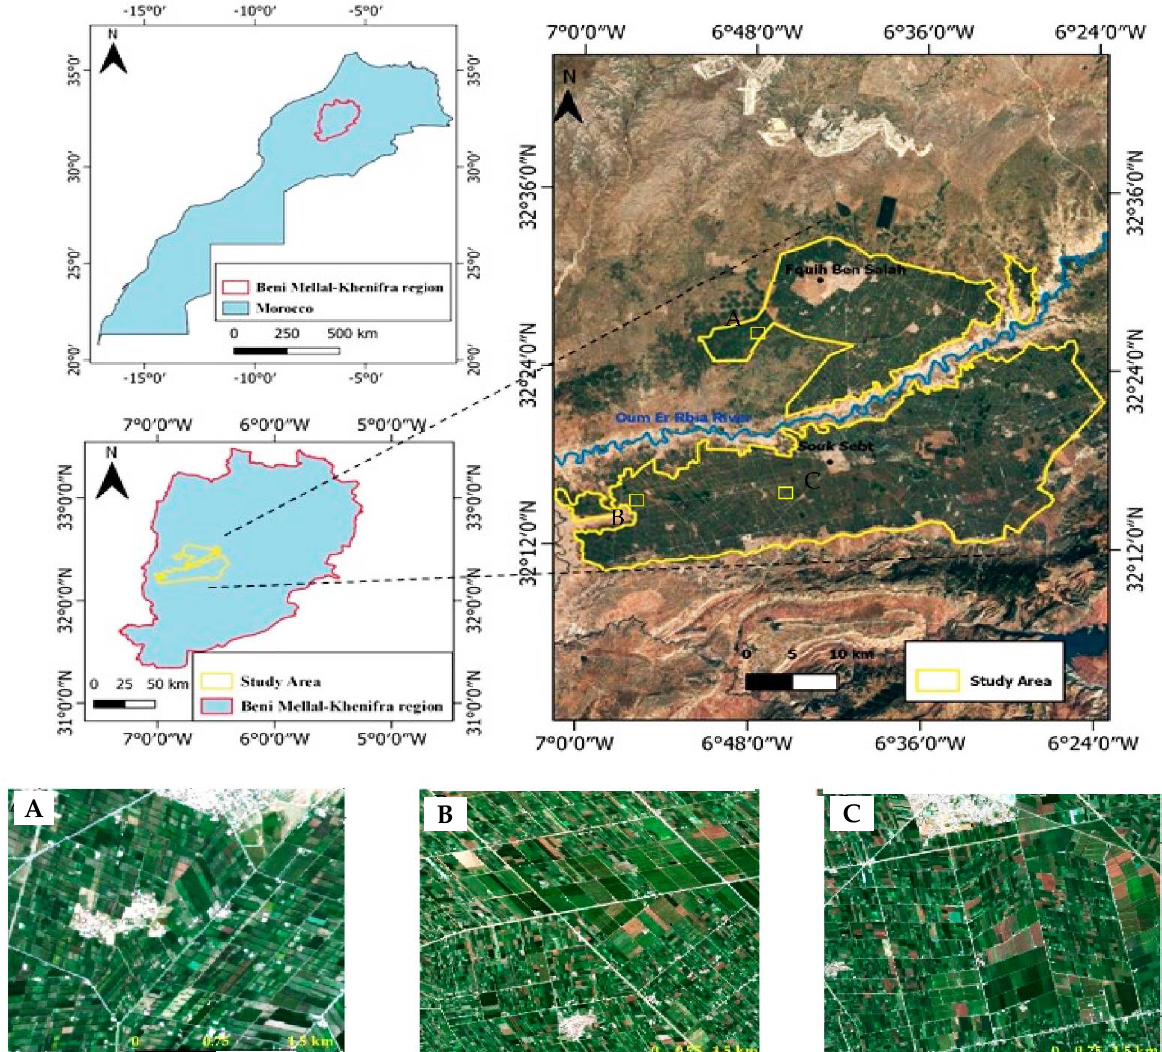
Figure 1. Location of the study area at the national scale ( left ). Scene of Tadla Irrigated Perimeter ( right ). ( A – C ) a detailed zoom of the study area Sentinel-2A image in true color.